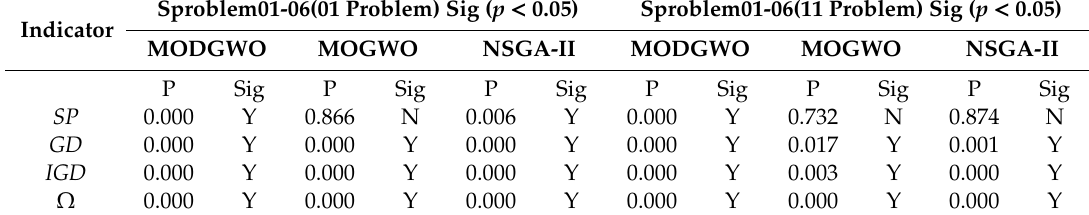
Table 9. Wilcoxon signed rank test (thre factories).